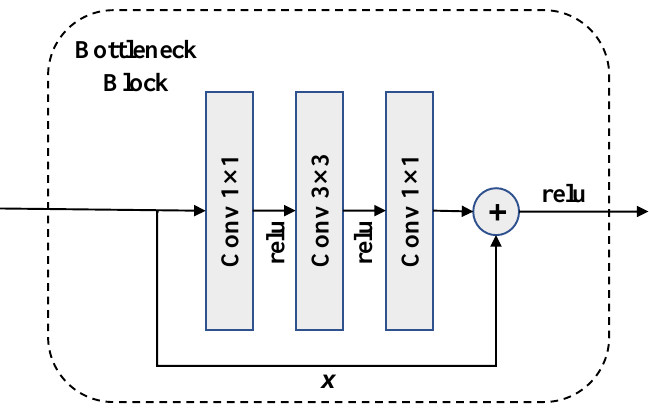
Figure 3. The structure of a bottleneck block, where x represents the input feature map, the fitting function of each block is F ( x ) and the expected latent mapping is H ( x ) . x fits H ( x ) together with F ( x ) by skip connection. Instead of learning H ( x ) directly, the structure learns the residual H ( x ) − x for reduced